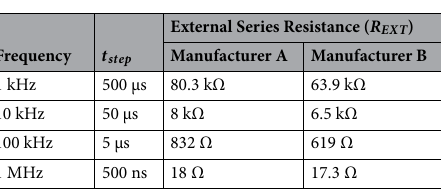
Figure 7. ( a ) Schematic cross-section of a planar power MOSFET biased in region A, showing the internal resistances and the gate-oxide capacitance, C ox ; ( b ) measurement circuit; ( c ) measurement circuit with equivalent circuit of the MOSFET.